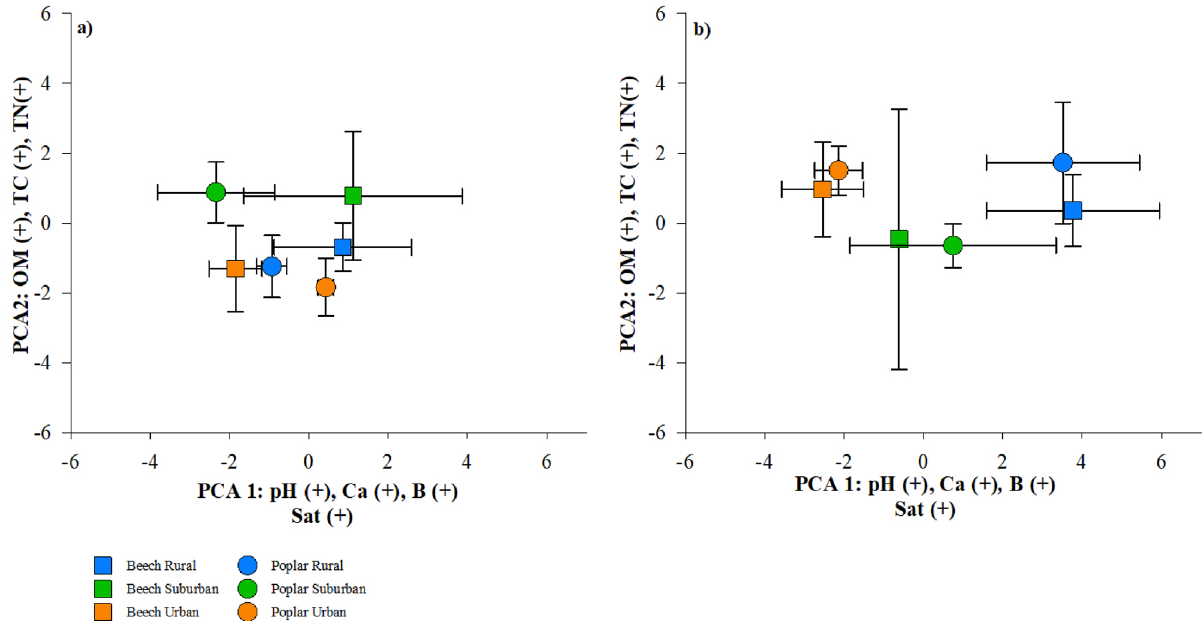
Figure 6. Principal Component Analysis (PCA) plotting PC1 and PC2 for soil samples collected from forest interior (a) and forest edge (b) comparing beech and yellow poplar (difference by shape) across rural–urban gradient (distinguished by color). Each point represents three sampled trees (± standard